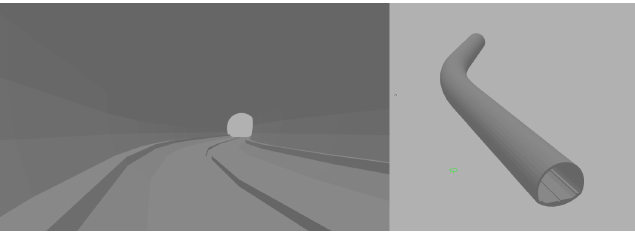
Figure 6. Inside ( Left ) and outside ( Right ) view of the simulated tunnel